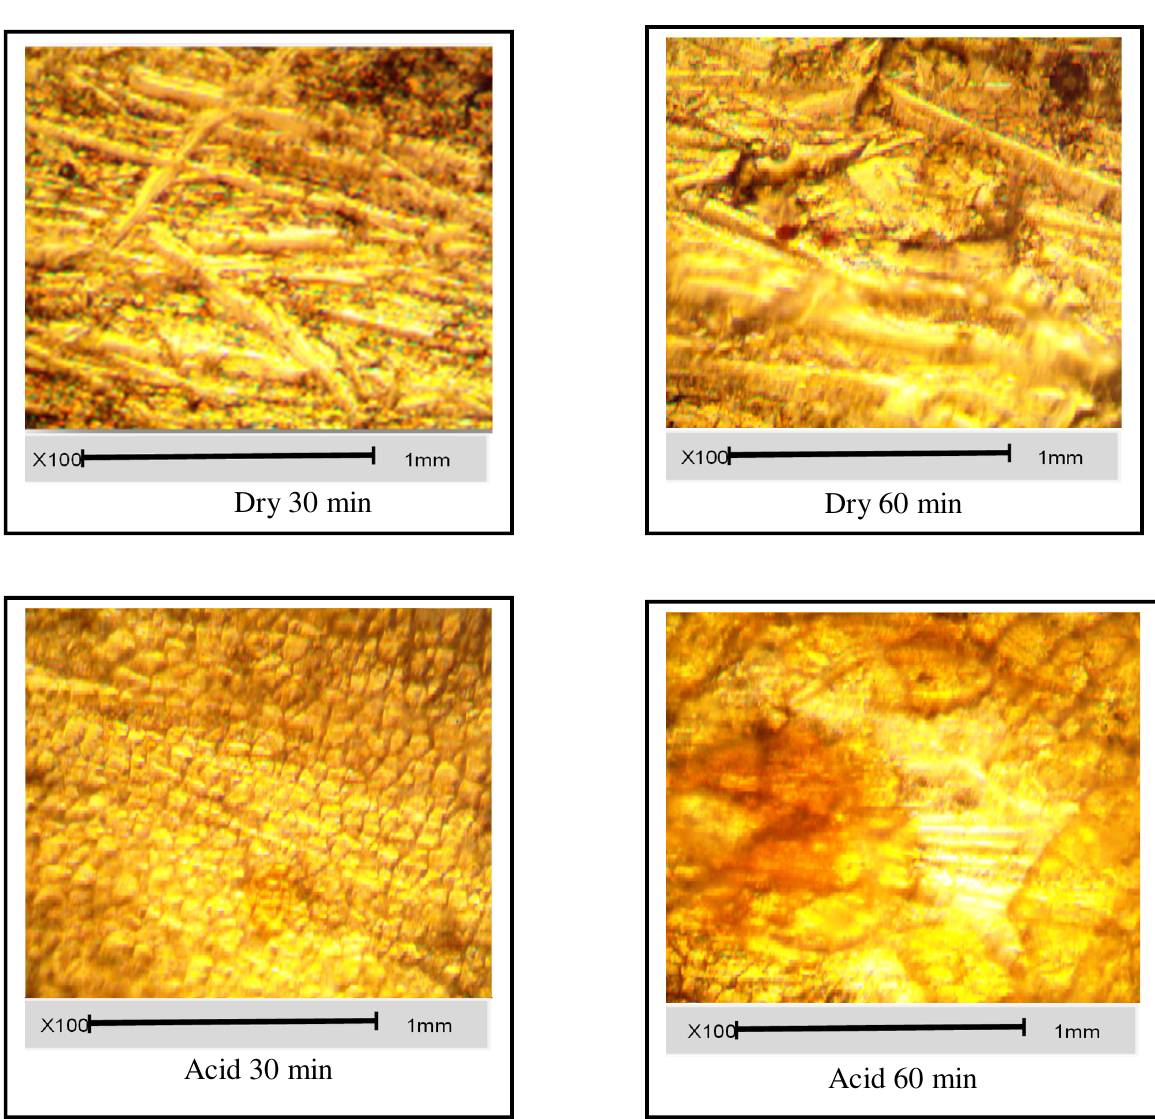
Fig. 11. Surface topographic and Microstructure of reference sample of AA 7075-T73